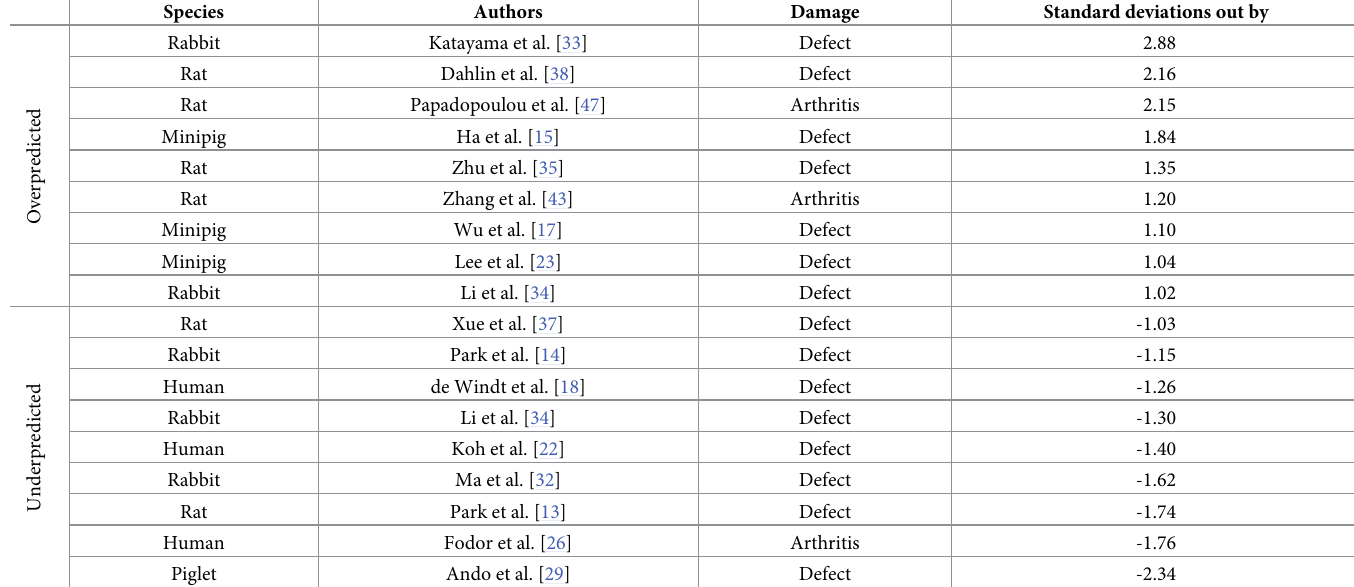
Table 1. The table highlights predicted entries where the number of standard deviations out by clinical results are greater than 1 or less than -1, which indicates our prediction is away from the experiments.